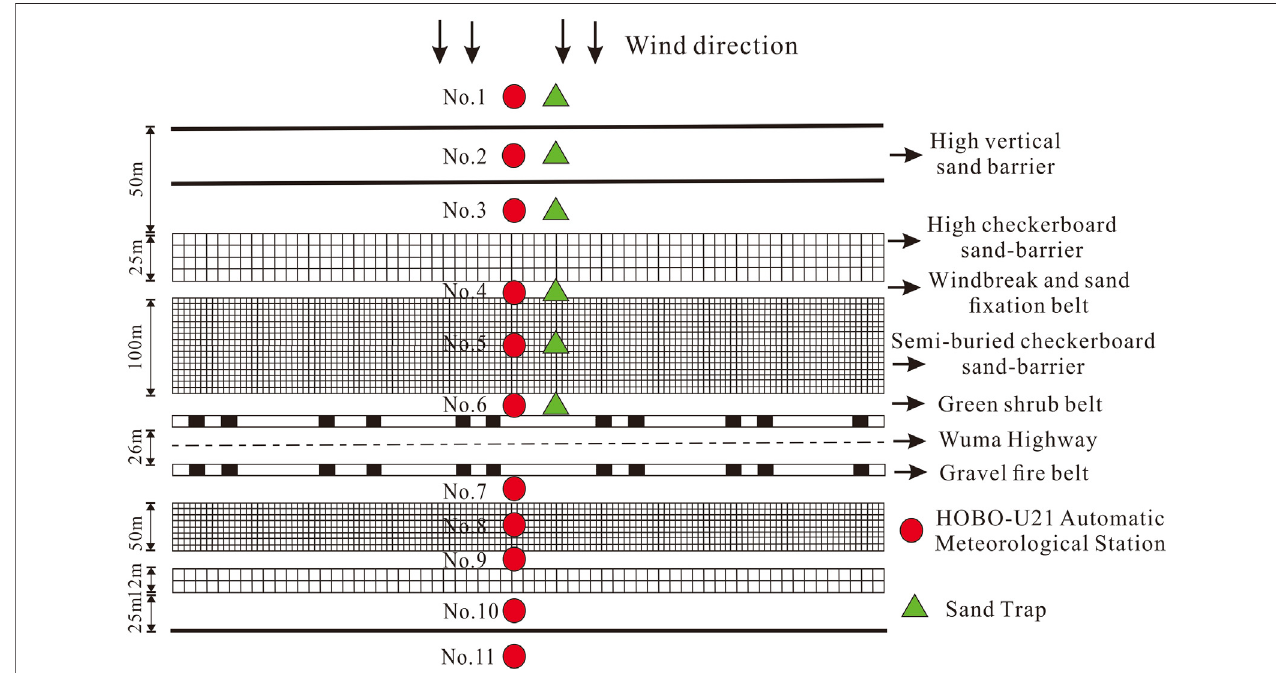
FIGURE 10 | Sand control system on the Tengger Desert section of the Wuhai – Maqin Highway and the site of the sand trap and HOBO-U21 automatic meteorological station.